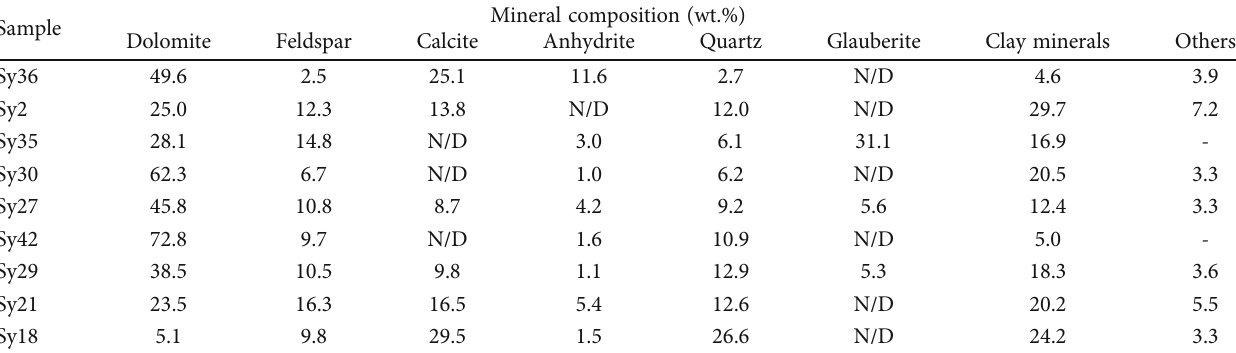
Table 1: Mineral compositions of the samples.